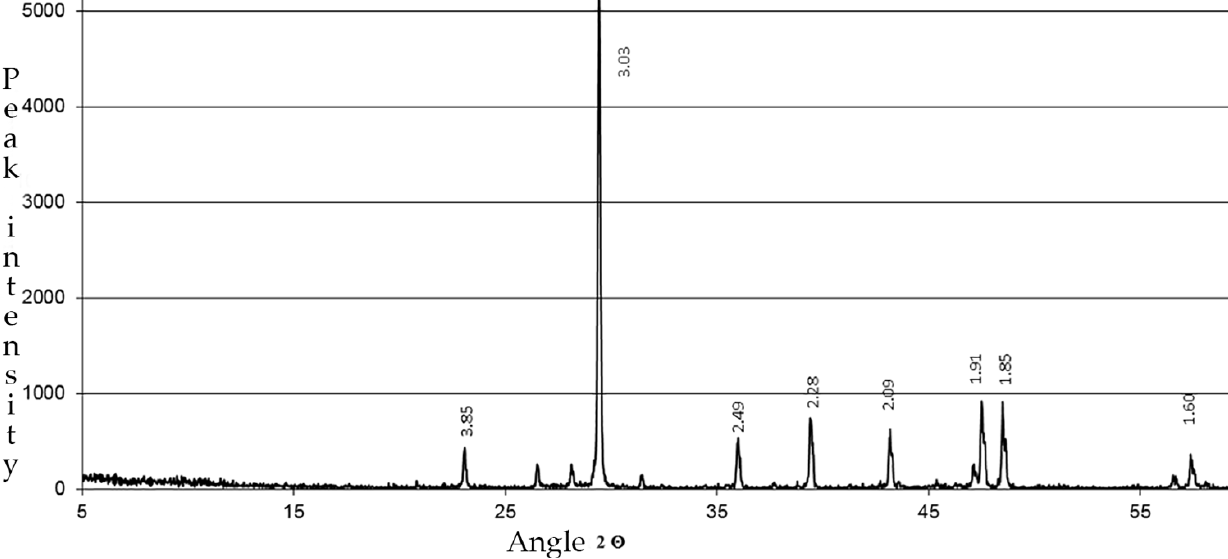
Figure 12. X-ray diffraction pattern of a masonry specimen on a lime mortar in the ancient city of Ephesus (1st century A.D.).